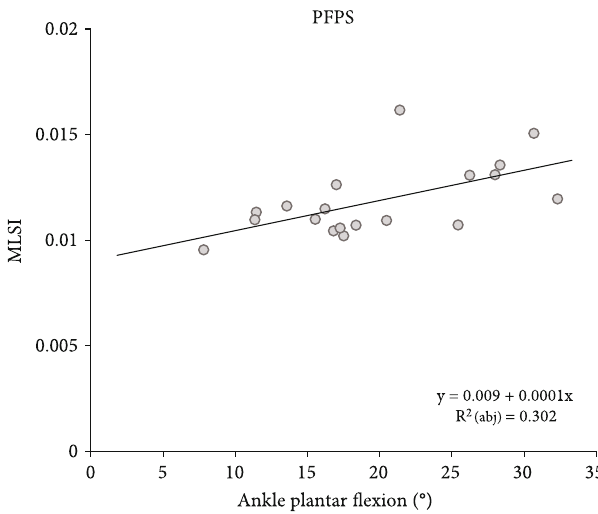
Figure 4: Results of linear regression analysis to PFPS group; results of linear regression analysis to PFPS group